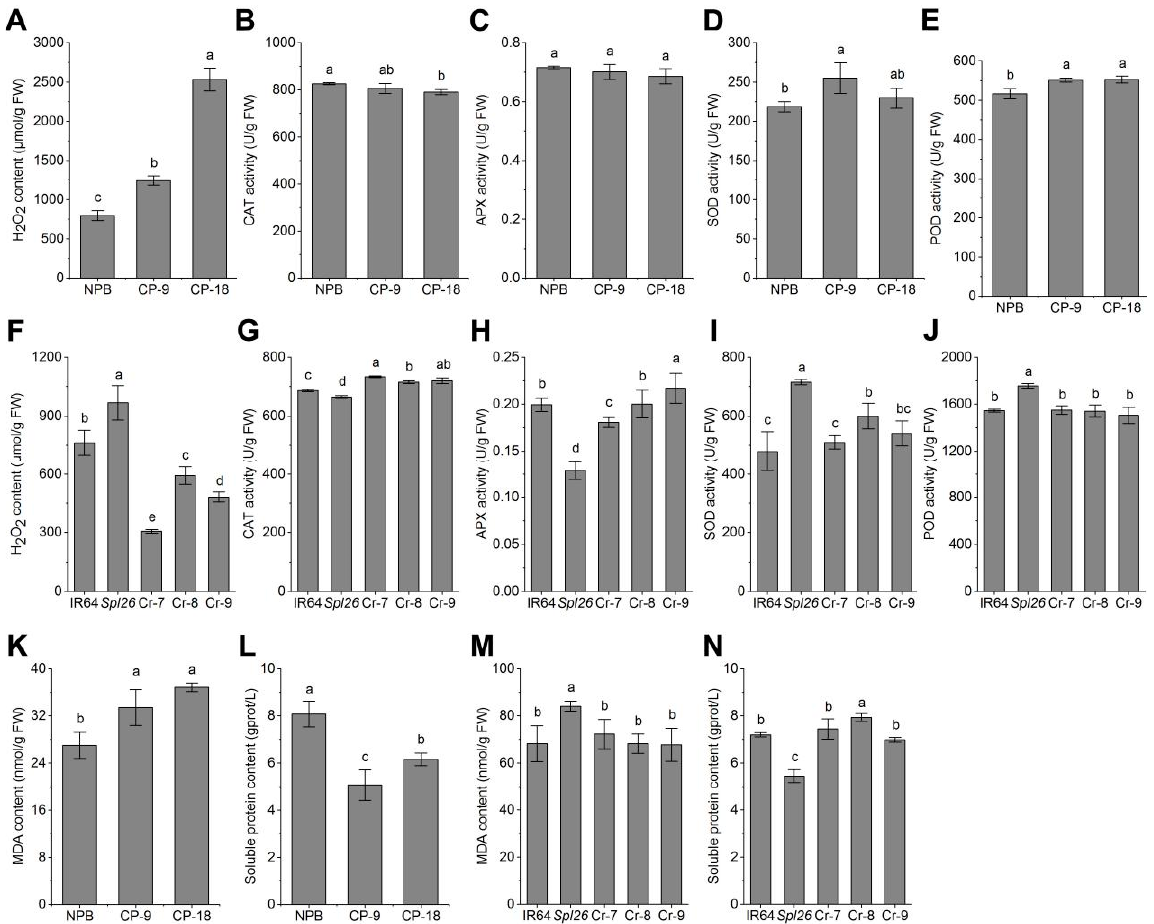
Figure 5. Physiological performance of transgenic lines and wild types at the tillering stage. ( A , F ) H 2 O 2 content; ( B , G ) CAT activity; ( C , H ) APX activity; ( D , I ) SOD activity; ( E , J ) POD activity; ( K , M ) MDA content; ( L , N ) Soluble protein content. Data are means ± SD ( n = 3), and different letters indicate significant differences at p < 0.05 by Duncan’s multiple test.